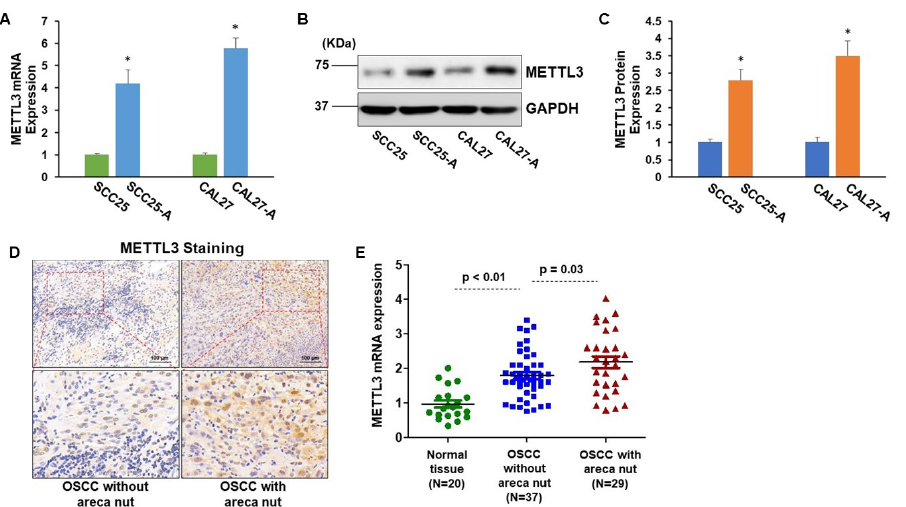
Figure 1. METTL3 is significantly elevated in arecoline-exposed OSCC cell lines and tissues. ( A ) The mRNA levels of METTL3 in SCC25, SCC25-A, CAL27, and CAL27-A were measured by RT-qPCR assay. ( B , C ) The expression levels of METTL3 in CAL27, SCC25, CAL27-A, and SCC25-A cells were assessed by Western blotting assay. The signal was quantified by Image J. ( D , E ) The METTL3 levels in normal oral tissues ( n = 20), OSCC without areca nut ( n = 37), and OSCC with areca nut ( n = 29) were tested using IHC staining ( D ) and RT-qPCR assay ( E ). * p < 0.05 compared to the control group. Table 1. The association between METTL3 expression and clinical parameters in 66 OSCC patients. Relative METTL3 mRNA Levels p -Value